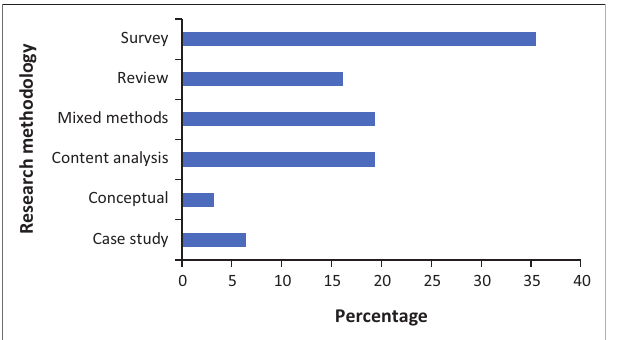
FIGURE 4: Research methodology and percentage of articles.